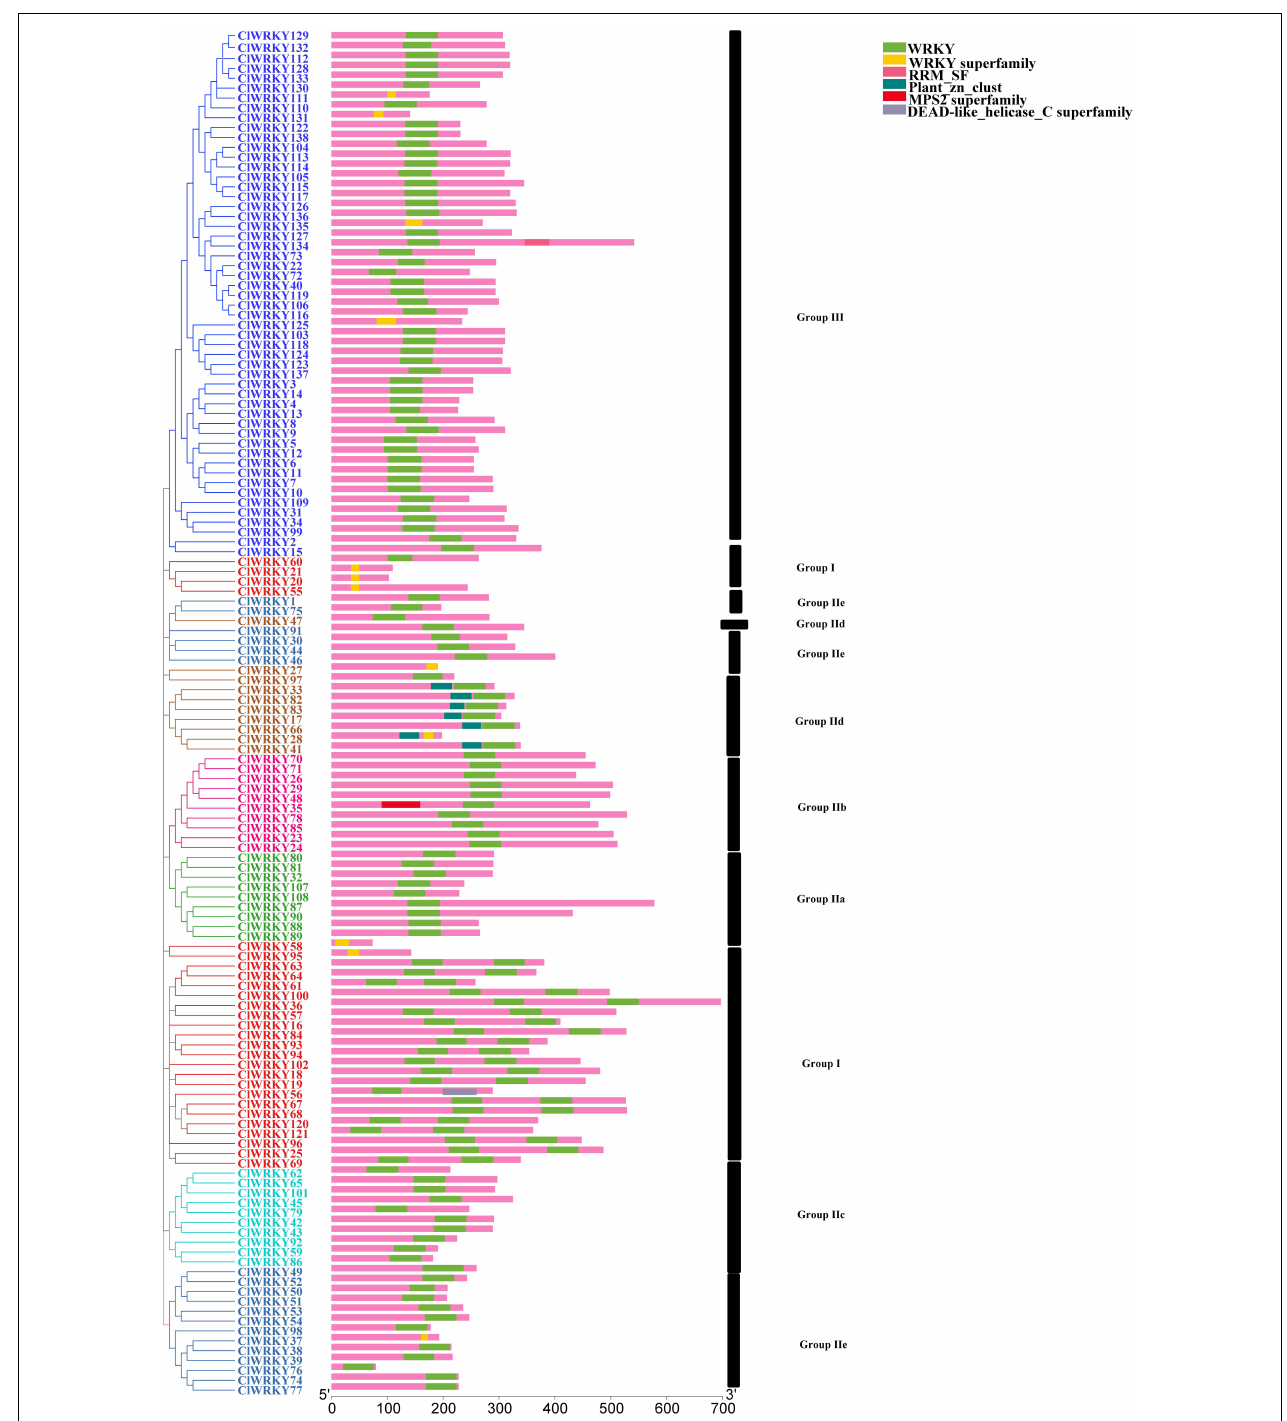
FIGURE 4 | Schematic diagram of conserved motifs in ClWRKY proteins according to the phylogenetic relationship. Different color ClWRKY members indicate different groups. The conserved motifs were predicted using the TBtools software.